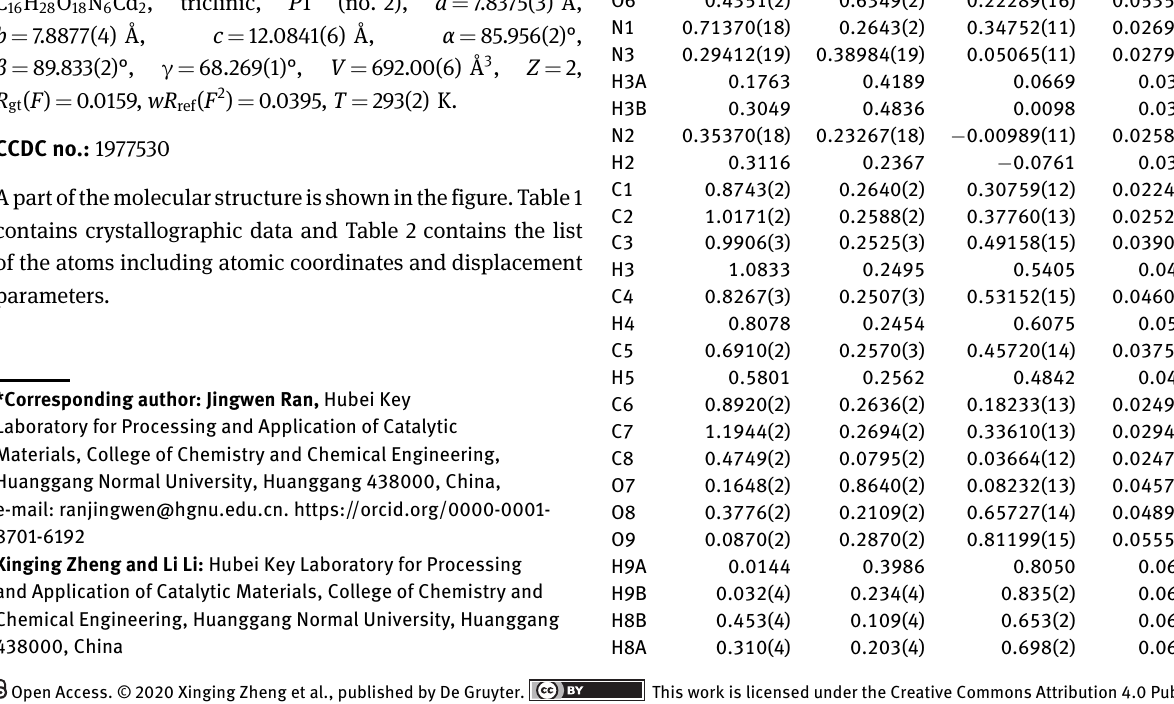
Apartofthemolecularstructureisshowninthefigure.Table1